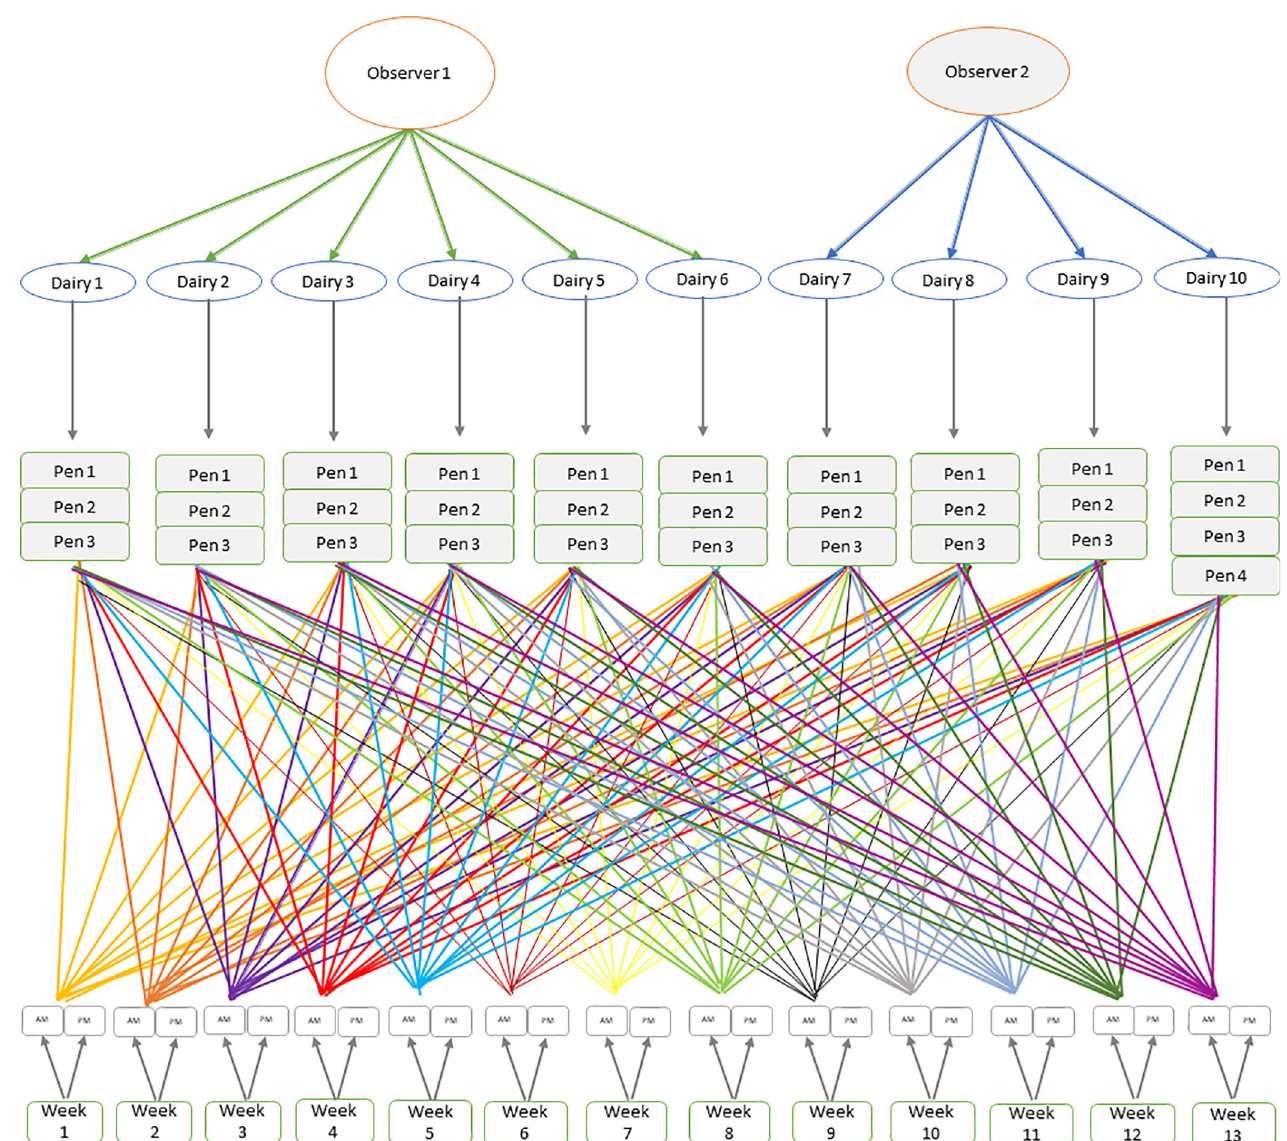
Fig 6. Boxplot of mean relative humidity during AM and PM counts and bunching according to the pen design. The upper and lower horizontal lines of the box represent the 25 th and 75 th percentiles respectively, the horizontal midline represents the median, the upper and lower horizontal whiskers lines are the upper and lower limits and the dots are the